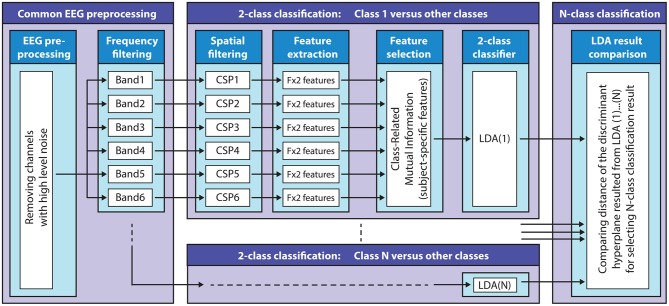
Filter-bank common spatial patterns (FBCSP) based multi-class classification method. The block diagram illustrates the structure of the FBCSP based multi-class classification method using a mutual information (MI) selection module and linear discriminant analysis (LDA) based classifier.